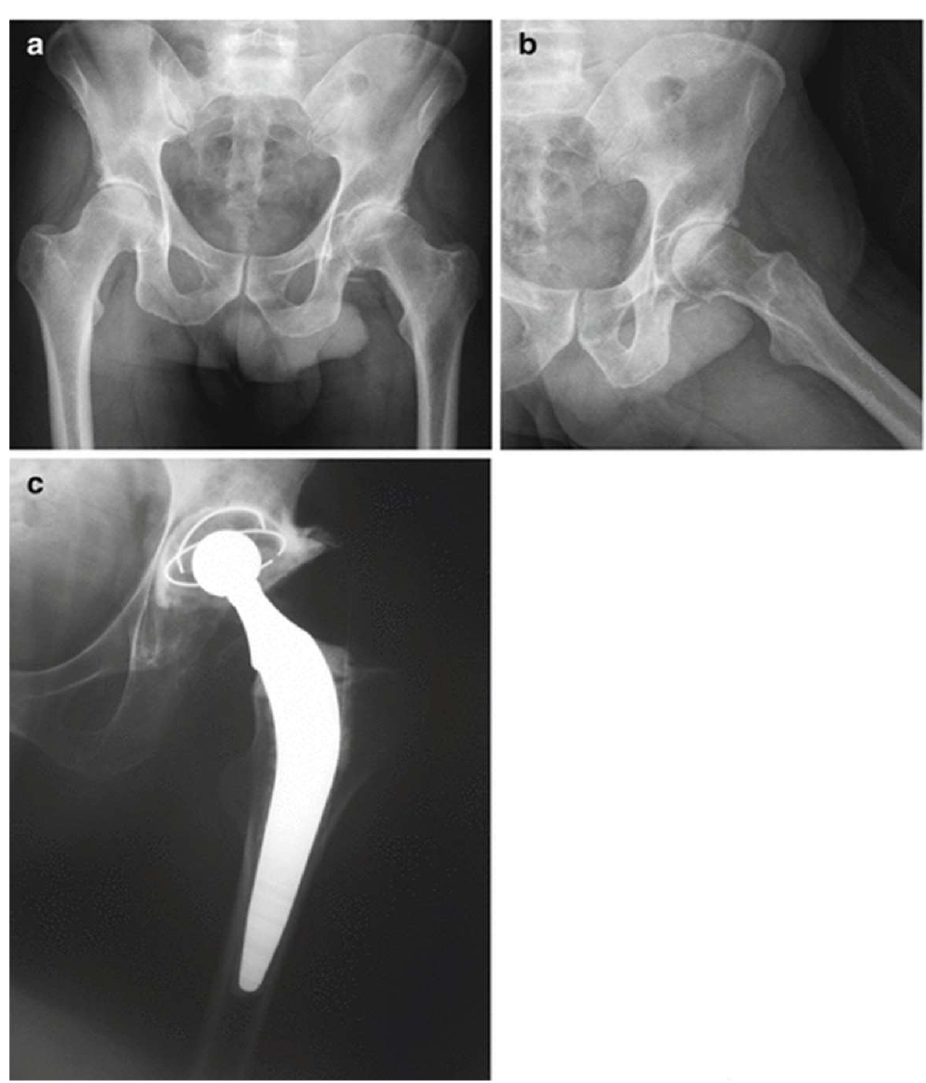
Figure 1. Total hip replacement (THR) in a haemophilia patient performed without using pharma- cological thromboprophylaxis. Anteroposterior preoperative radiograph ( a ). Lateral preoperative view ( b ). Postoperative radiograph ( c ).